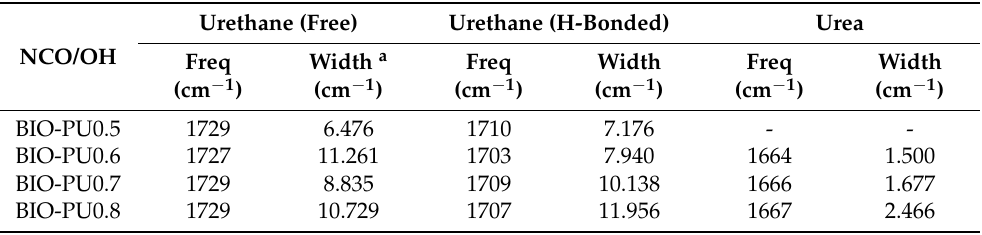
Table 2. Characteristics of the urethane (free and H-bonded) of BIO-PU films in carbonyl region.